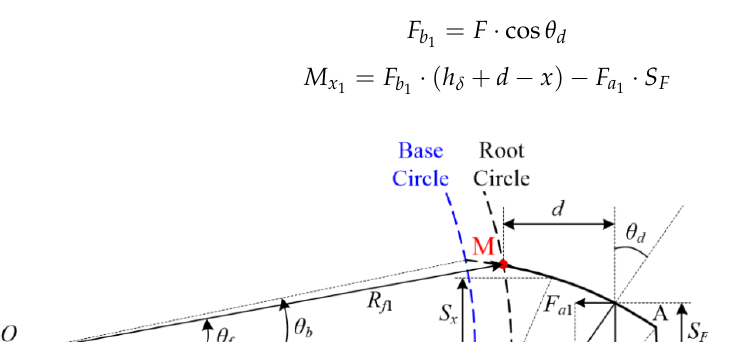
Machines 2022 , 10 , 271 10 of 26